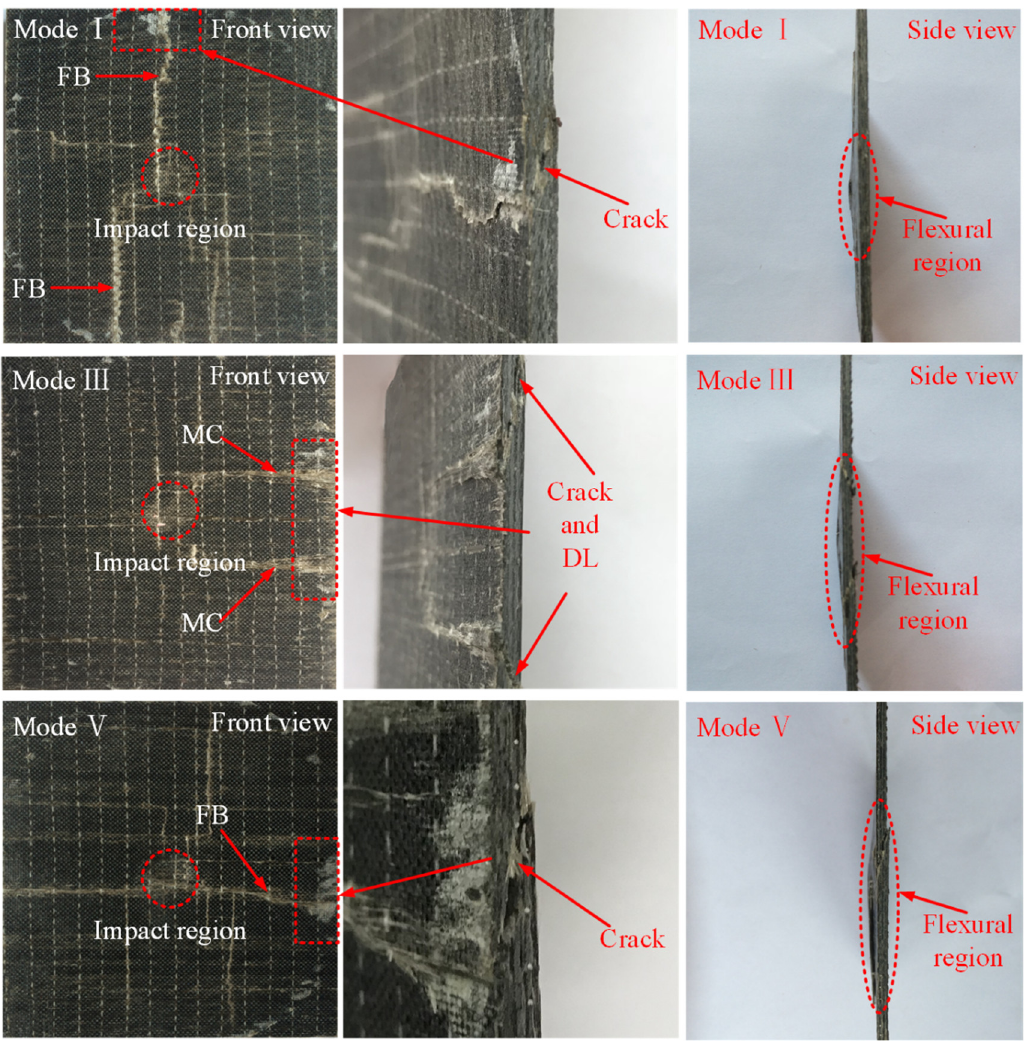
Figure 7. Typical damage modes of the samples with 90 J impact. Notes: in the figure, MC indicates the matrix cracking, FB represents the fiber breakage and DL describes the delamination.